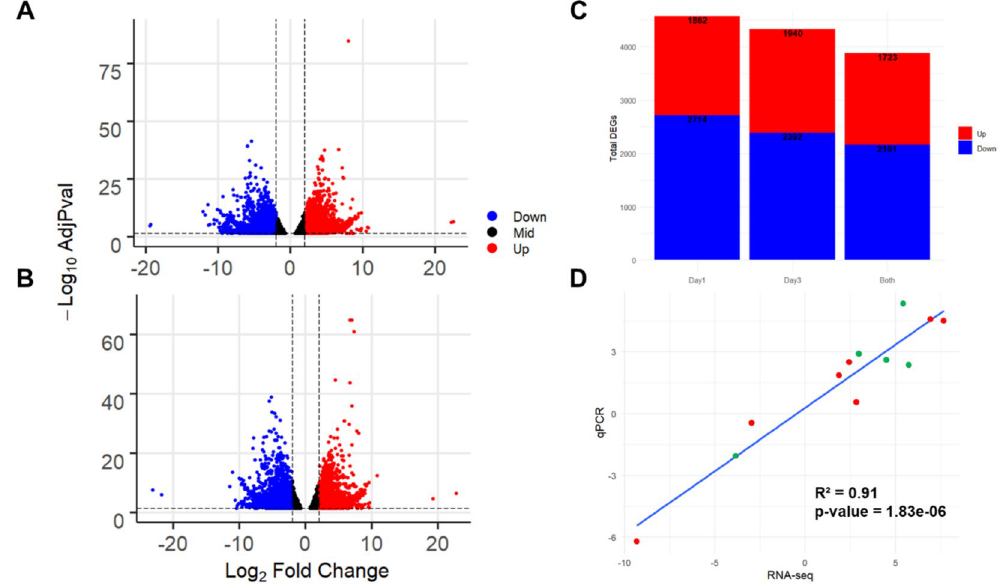
Figure 2. Gene expression patterns of RNA-seq and correlation with RT-qPCR. ( A ) Volcano plot of differentially expressed transcripts (DETs) at day 1 of regeneration. ( B ) Volcano plot of DETs at day 3 of regeneration. ( C ) Bar plots show upregulated and downregulated DETs in one or both days of regeneration. ( D ) Plot showing correlation line, squared Pearson correlation coefficient and p-value between 12 expression values (Log2FC) of seven genes in regeneration stages compared to the normal stage. RNA-seq values are located in the x axis and RT-qPCR values are located on the y axis. Green colored points are from day 1 values, while red colored are from day